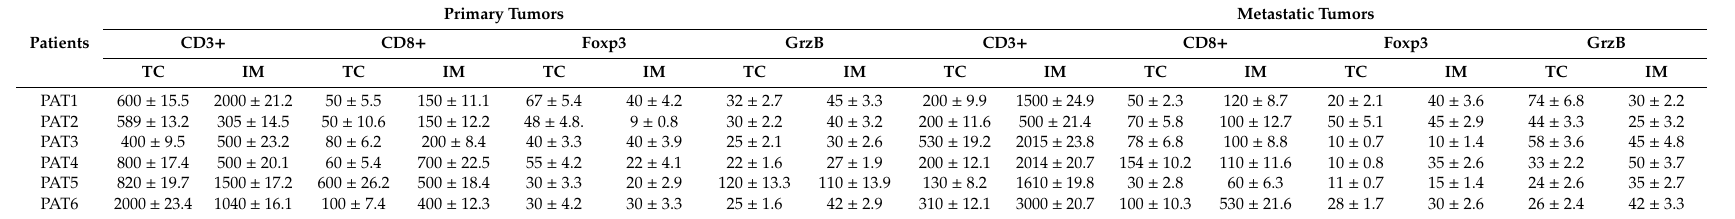
Table 4. Distribution of T-cell subsets densities (cells / mm 2 ) in primary and metastatic